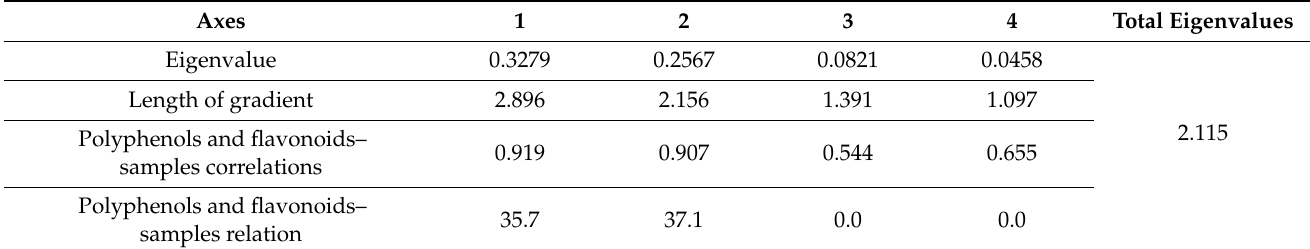
Table 6. Variance explained by the first four DCA axes (Figure